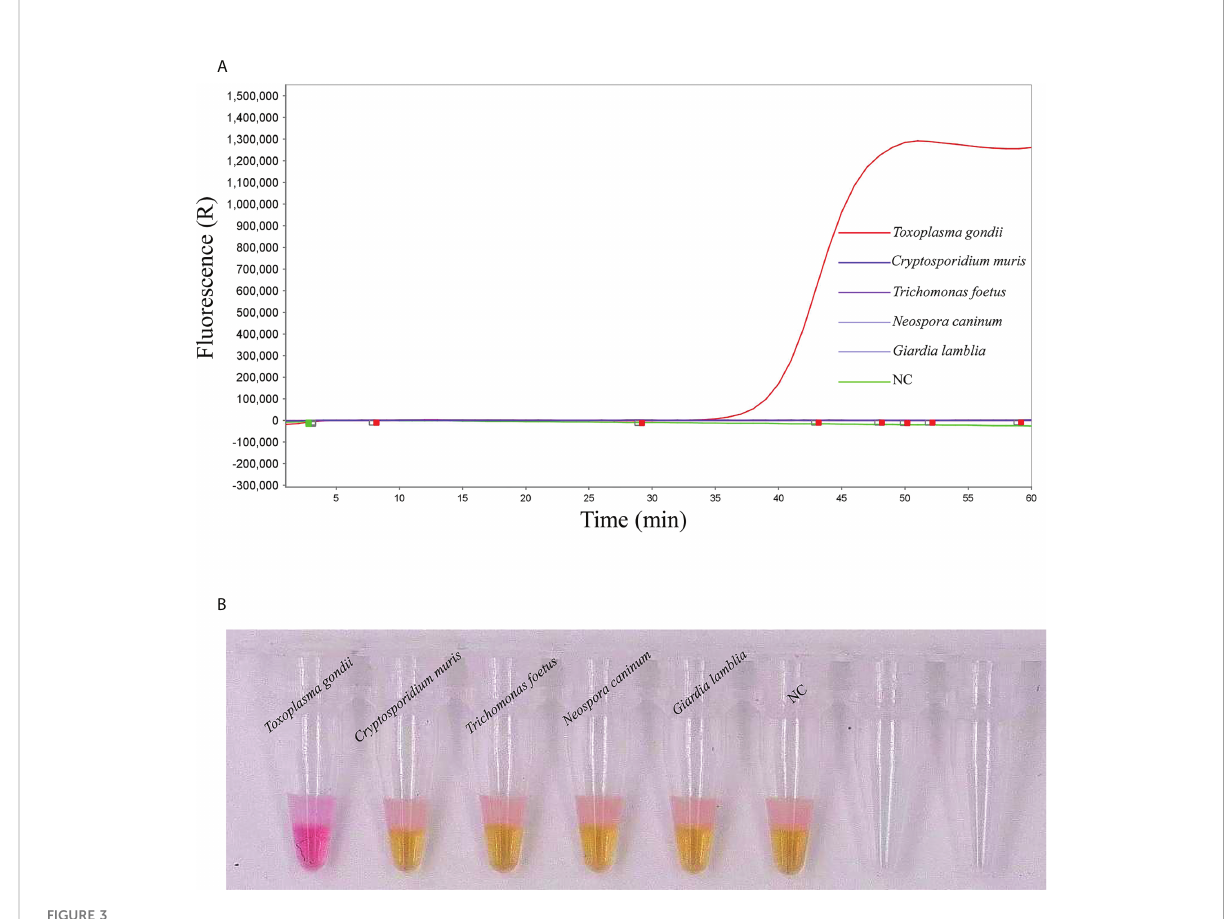
FIGURE 3 Detection speci fi city of T. gondii positive standard plasmids analysed using qLAMP and visual LAMP. (A) Speci fi city results for qLAMP, (B) Speci fi city results for visual LAMP in detecting Giardia lamblia , Trichomonas foetus , Cryptosporidium muris and Neospora caninum . NC, Negative control, nuclease-free